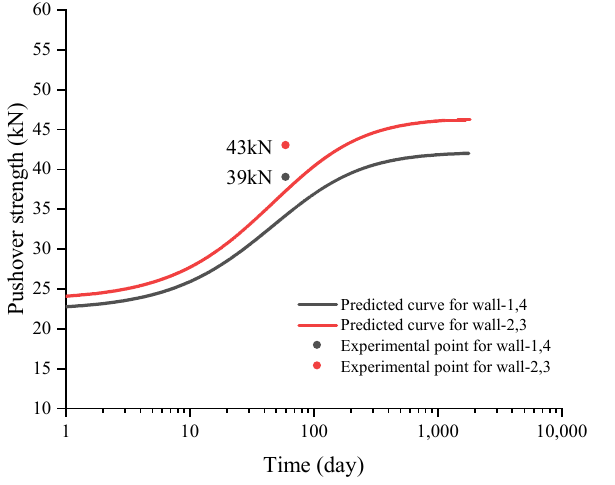
Predicted curve for wall-1,4 Predicted curve for wall-2,3 Experimental point for wall-1,4 Experimental point for wall-2,3